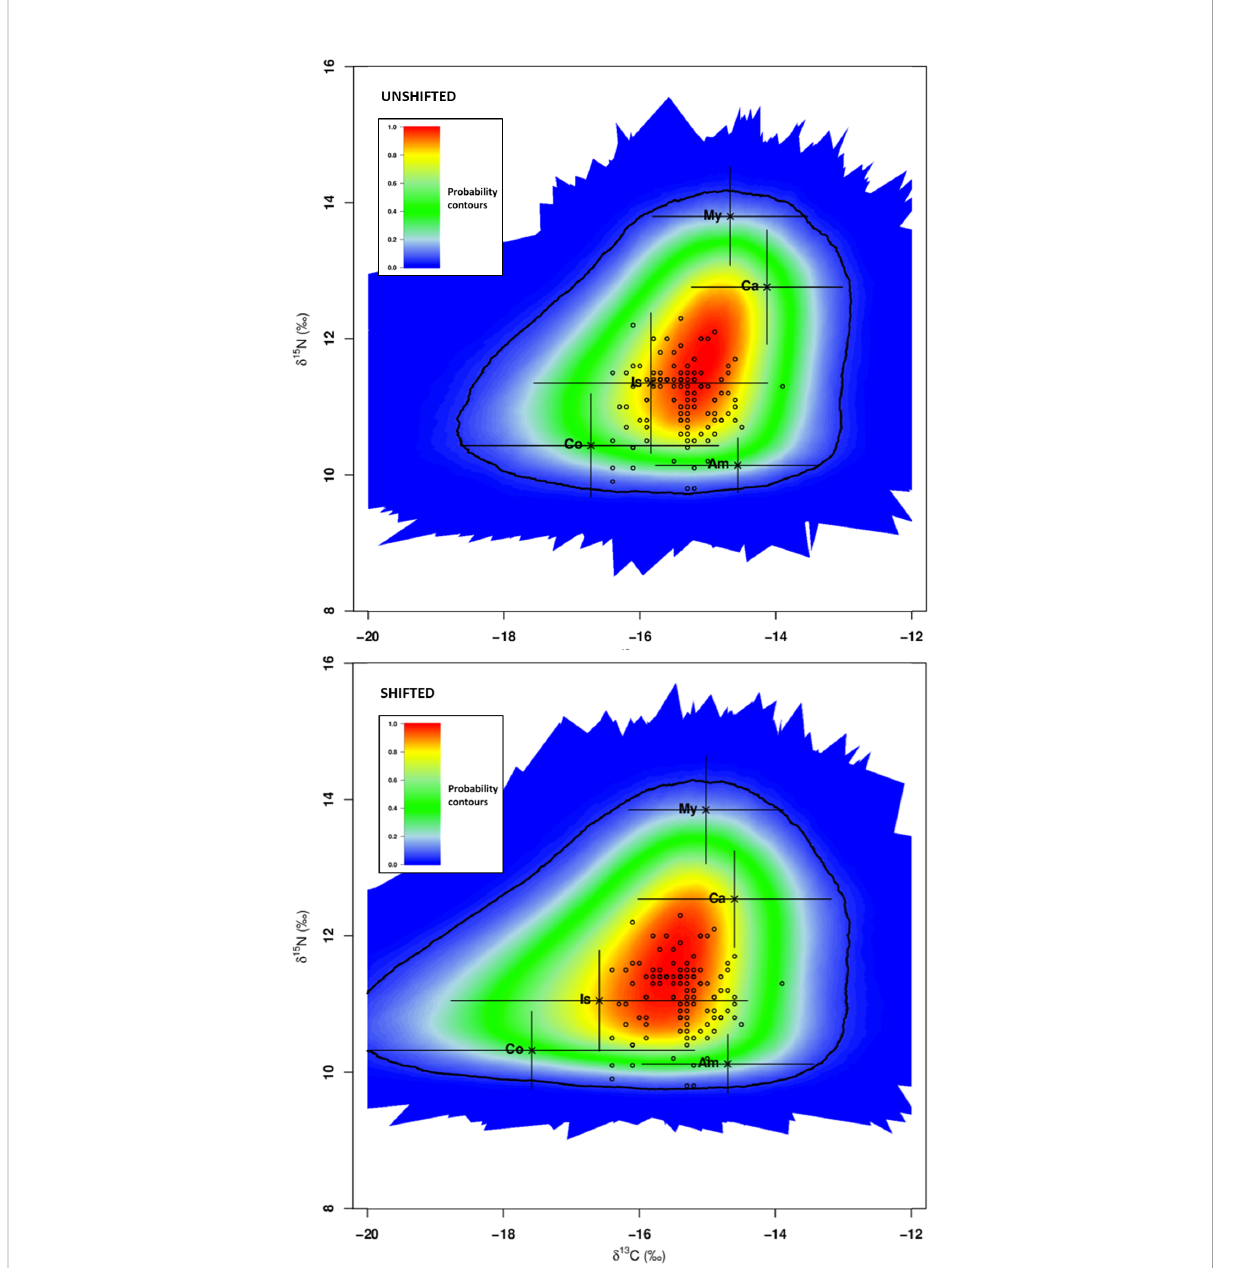
FIGURE 4 Global assessment - SIMM polygon for Syngnathus acus (n=110; 2017 and 2018 surveys) relative to average d 13 C and d 15 N signatures of fi ve potential prey sources (mean ± sd; black crosses) adjusted for TDF values and consumers ( S. acus ; open circles; fi ve outliers not included). Treatments: average isotopic values of potential prey sampled concomitantly with consumers (Unshifted) or in the previous season of consumer sampling (Shifted). The coloured region represents the 95% con fi dence interval. Probability contours are at the 5% level. Sources: Am